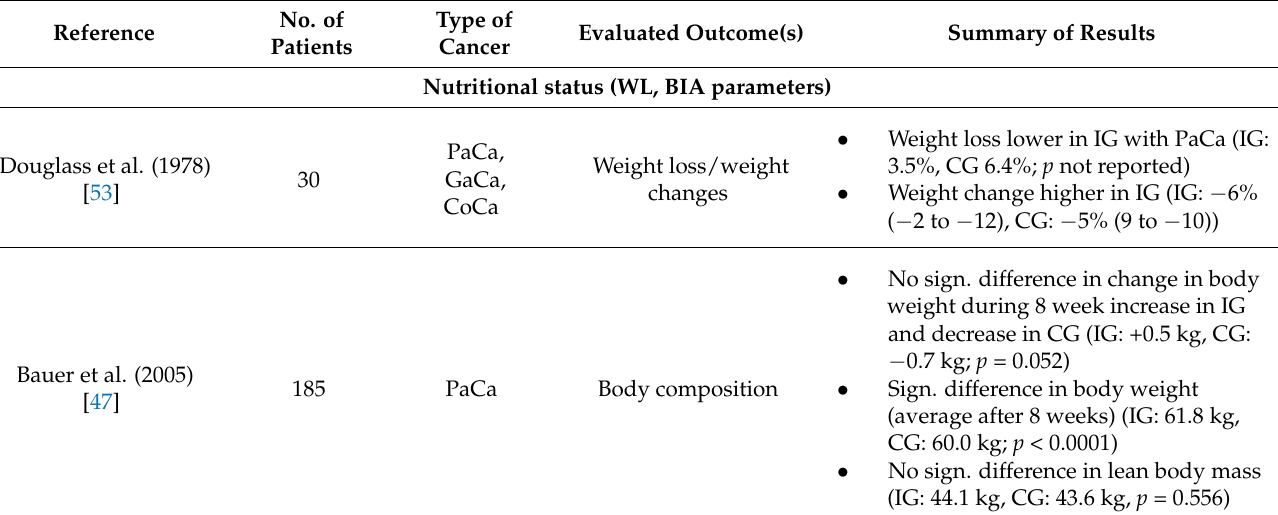
Table 4. Randomized controlled trials of dietary